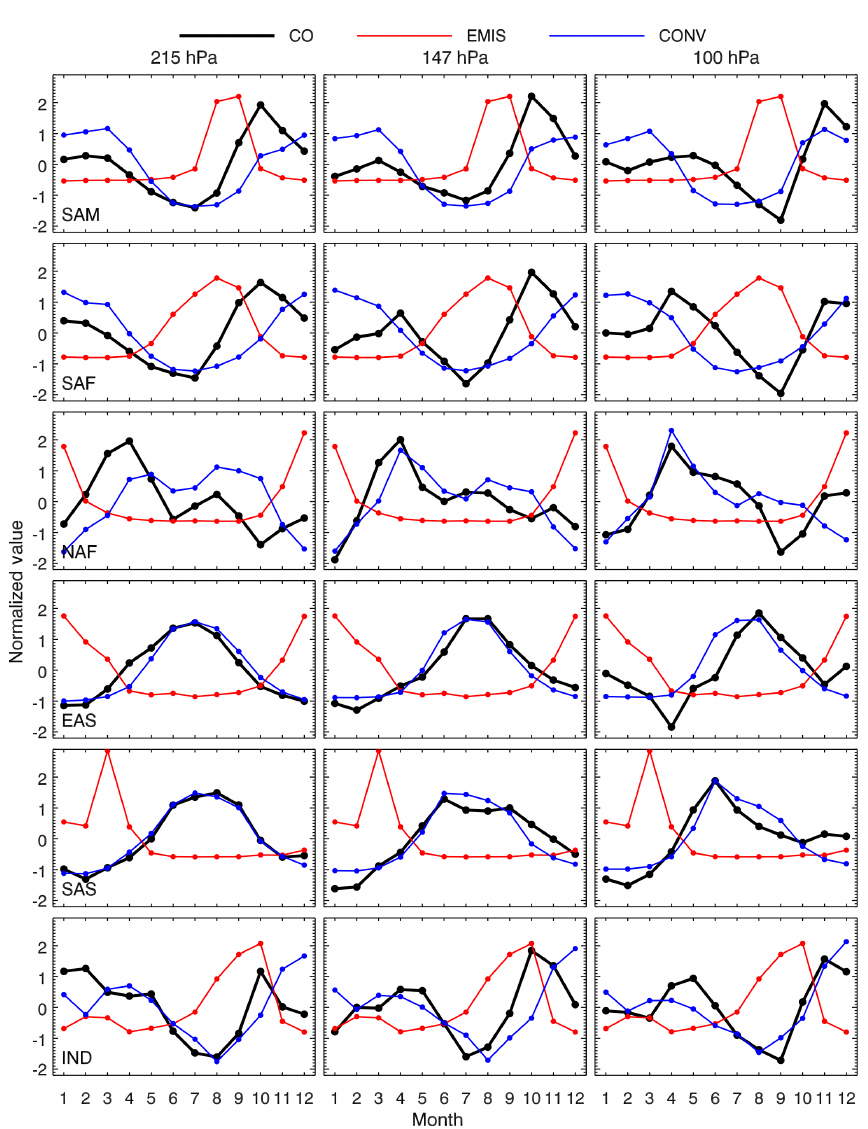
Figure 15. Climatological monthly mean of surface CO emission from GMI model (red line), ice water content (blue line) and CO mixing ratio (black line) at 215hPa (left column), 147hPa (middle column) and 100hPa (left column) from MLS observation over six regions: (top row) South America, (second row from top) southern Africa, (third row from top) northern Africa, (fourth row from top) East Asia, (fifth row from top) South Asia and (bottom row) Indonesia. Each variable is normalized for